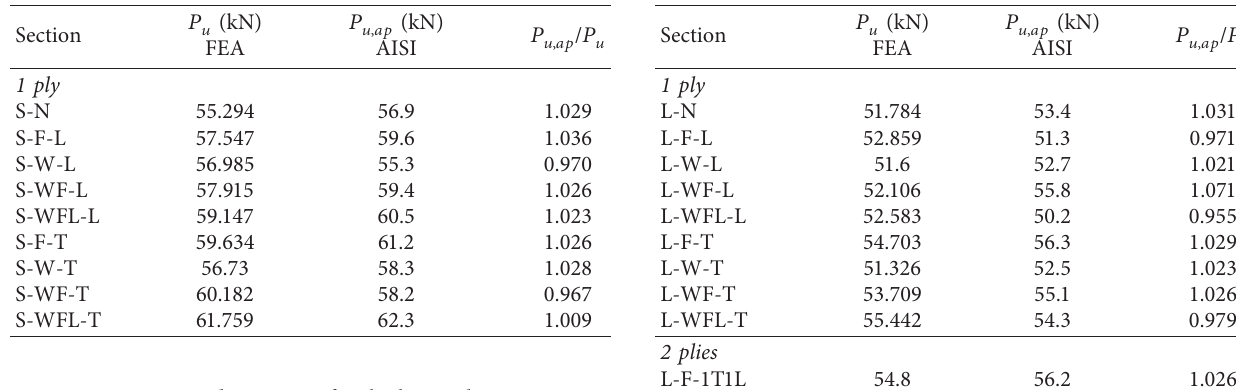
Table 8: Load estimates, for the short columns.